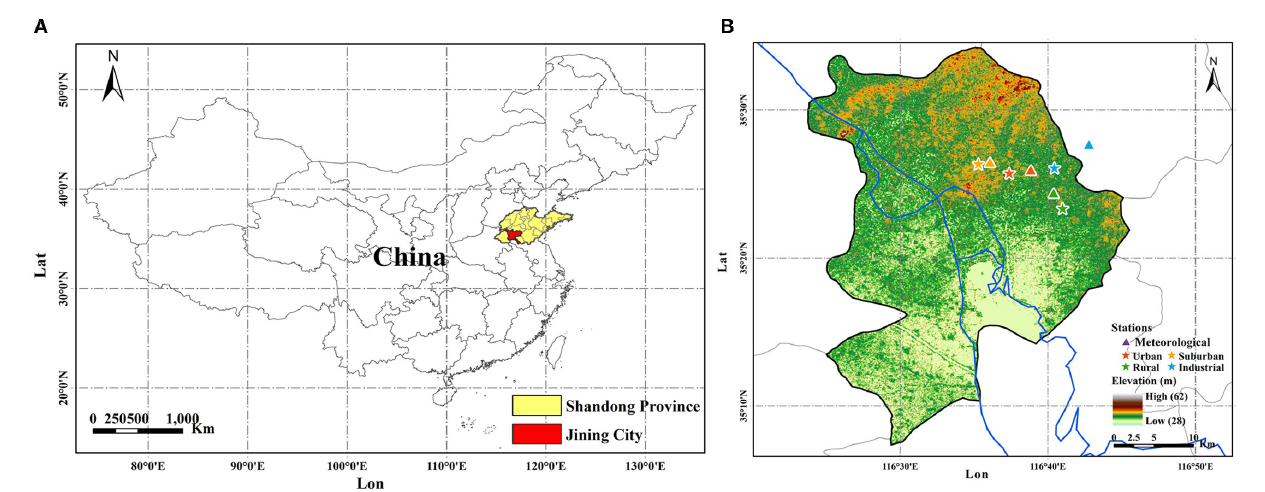
FIGURE1 The location of Jining in Shandong Province (A) , and the meteorology and air quality stations (B) in Jining city. Colored stars and triangles represent air quality sites and meteorological site in four functional areas (Suburban: orange, Urban: red, Rural: green, Industry: